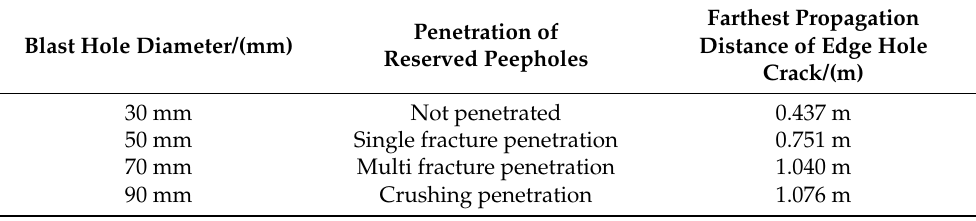
Table 4. Propagation table of blasting through cracks with different blast hole